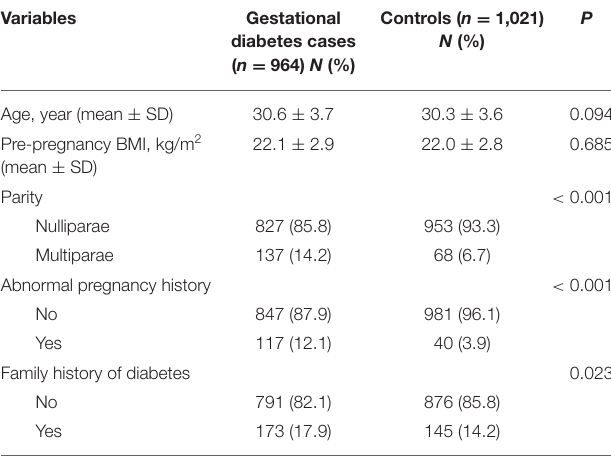
TABLE 1 | Demographic and selected variables in gestational diabetes cases and